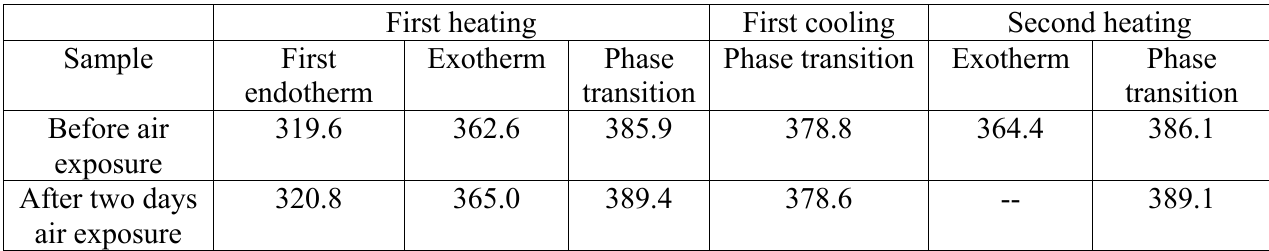
Table 2. Peak temperature (in K) measured in PDSC scans of unmilled LiBH after air exposure. Heating and cooling rates: 20 K min –1 . Uncertainty in all measurements is ± 0.1 K.